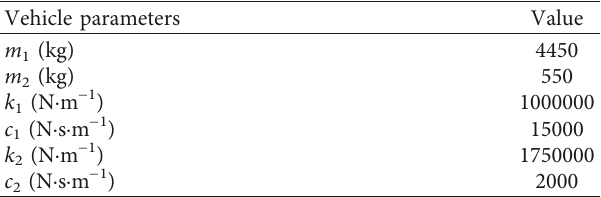
Table 1: The parameters of medium truck. Vehicle